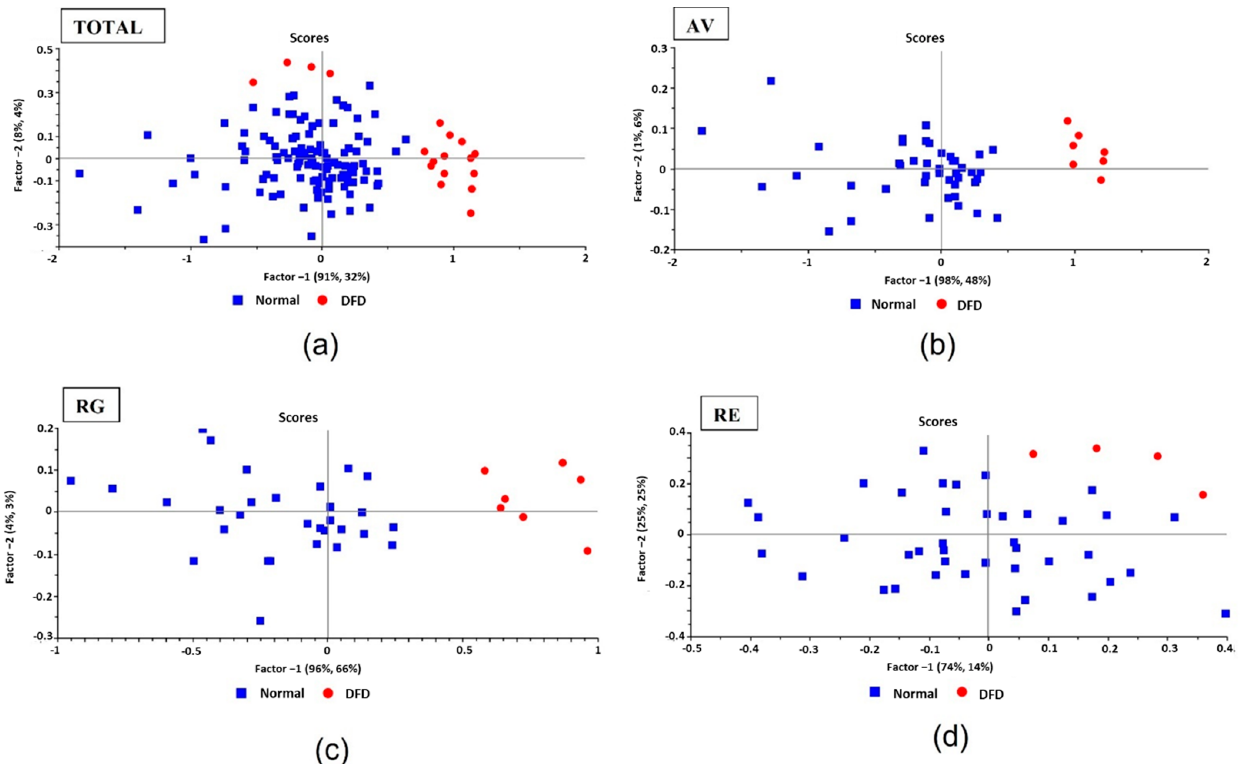
Figure 2. PLS-DA analysis after absorbance (log 1/R): 2D scatter plot of scores of total meat spectra data from: ( a ) Total (1000–2500 nm); ( b ) Asturiana de los Valles (AV; 1000–1800 nm); ( c ) Rubia Gallega (RG; 1000–1800 nm); and ( d ) Retinta (RE; 1000–1800 nm) sample sets. Graphical representation of PC1 (91%, 32%; 98%, 48%; 93%, 66%; and 74%, 14%, respectively) vs. PC2 (8%, 4%; 1%, 4%; 3%, 3%; and 25%, 25%, respectively). Red dots: DFD samples; blue squares: Normal samples.